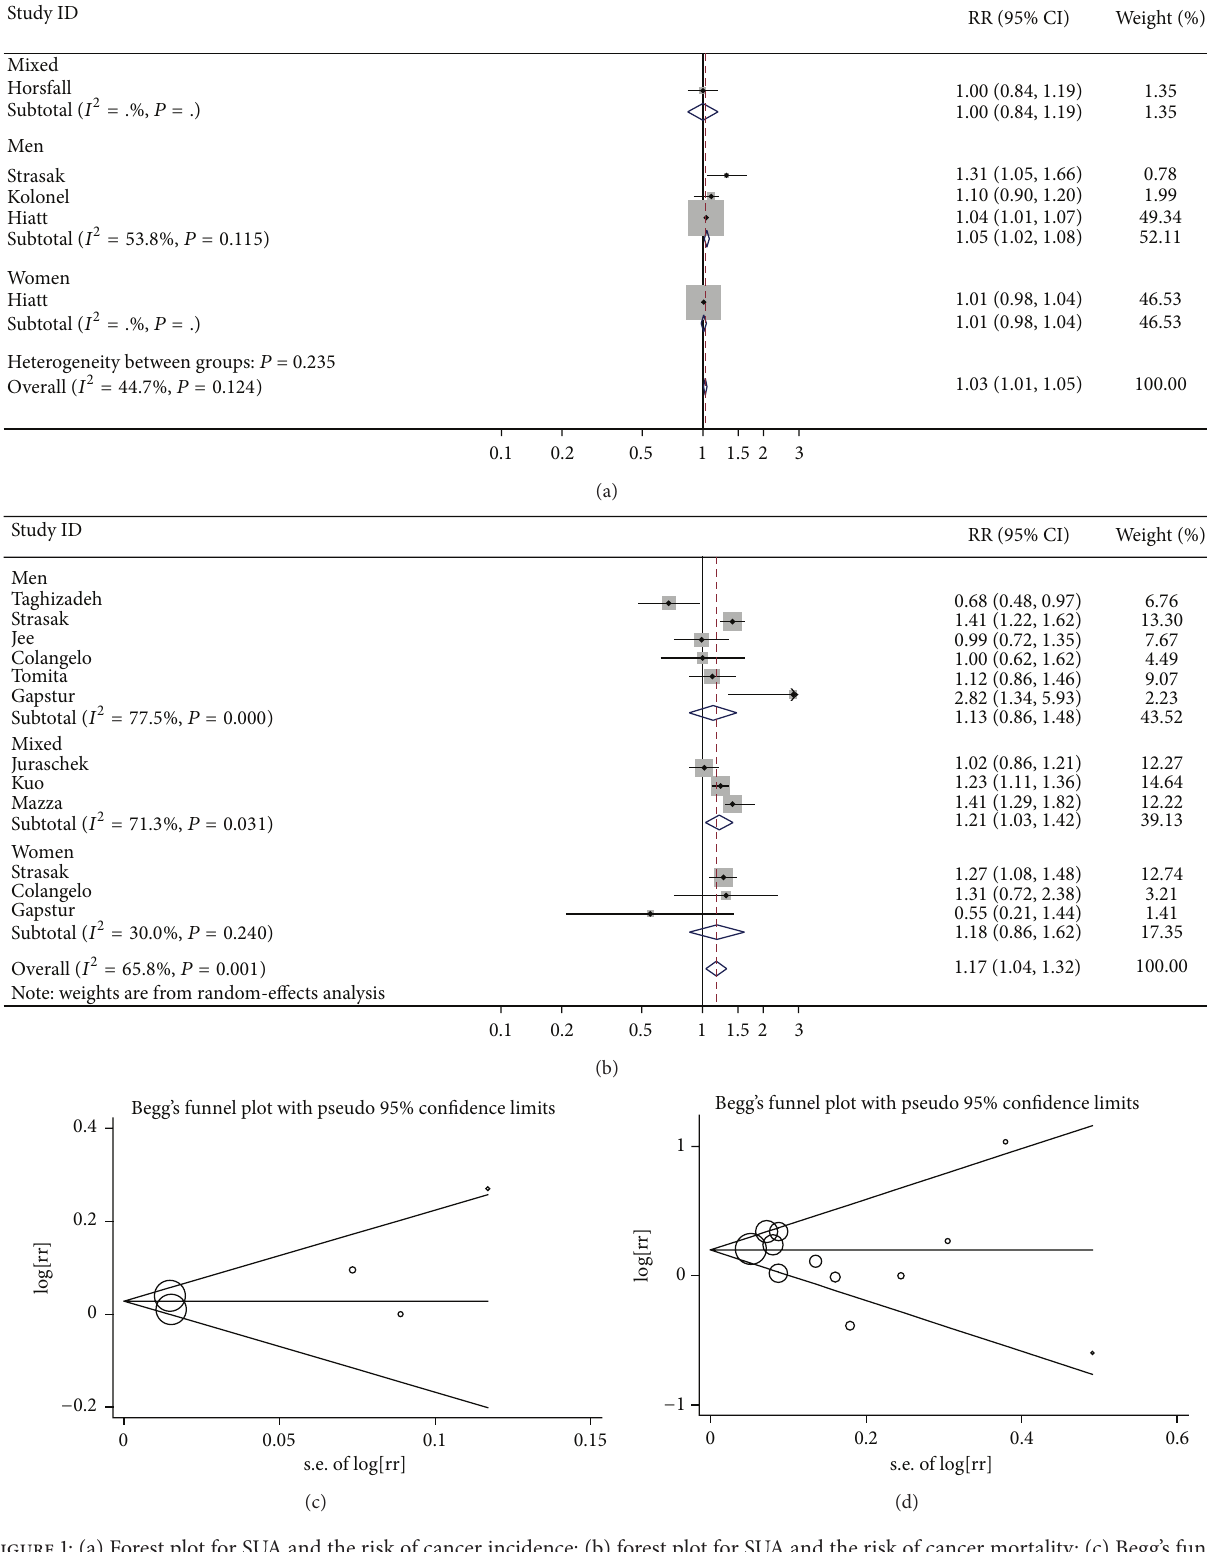
Figure 1: (a) Forest plot for SUA and the risk of cancer incidence; (b) forest plot for SUA and the risk of cancer mortality; (c) Begg’s funnel plots for the risk of cancer incidence ( 𝑃 value for Egger’s test equal to 0.295); (d) Begg’s funnel plots for the risk of cancer mortality ( 𝑃 value for Egger’s test equal to